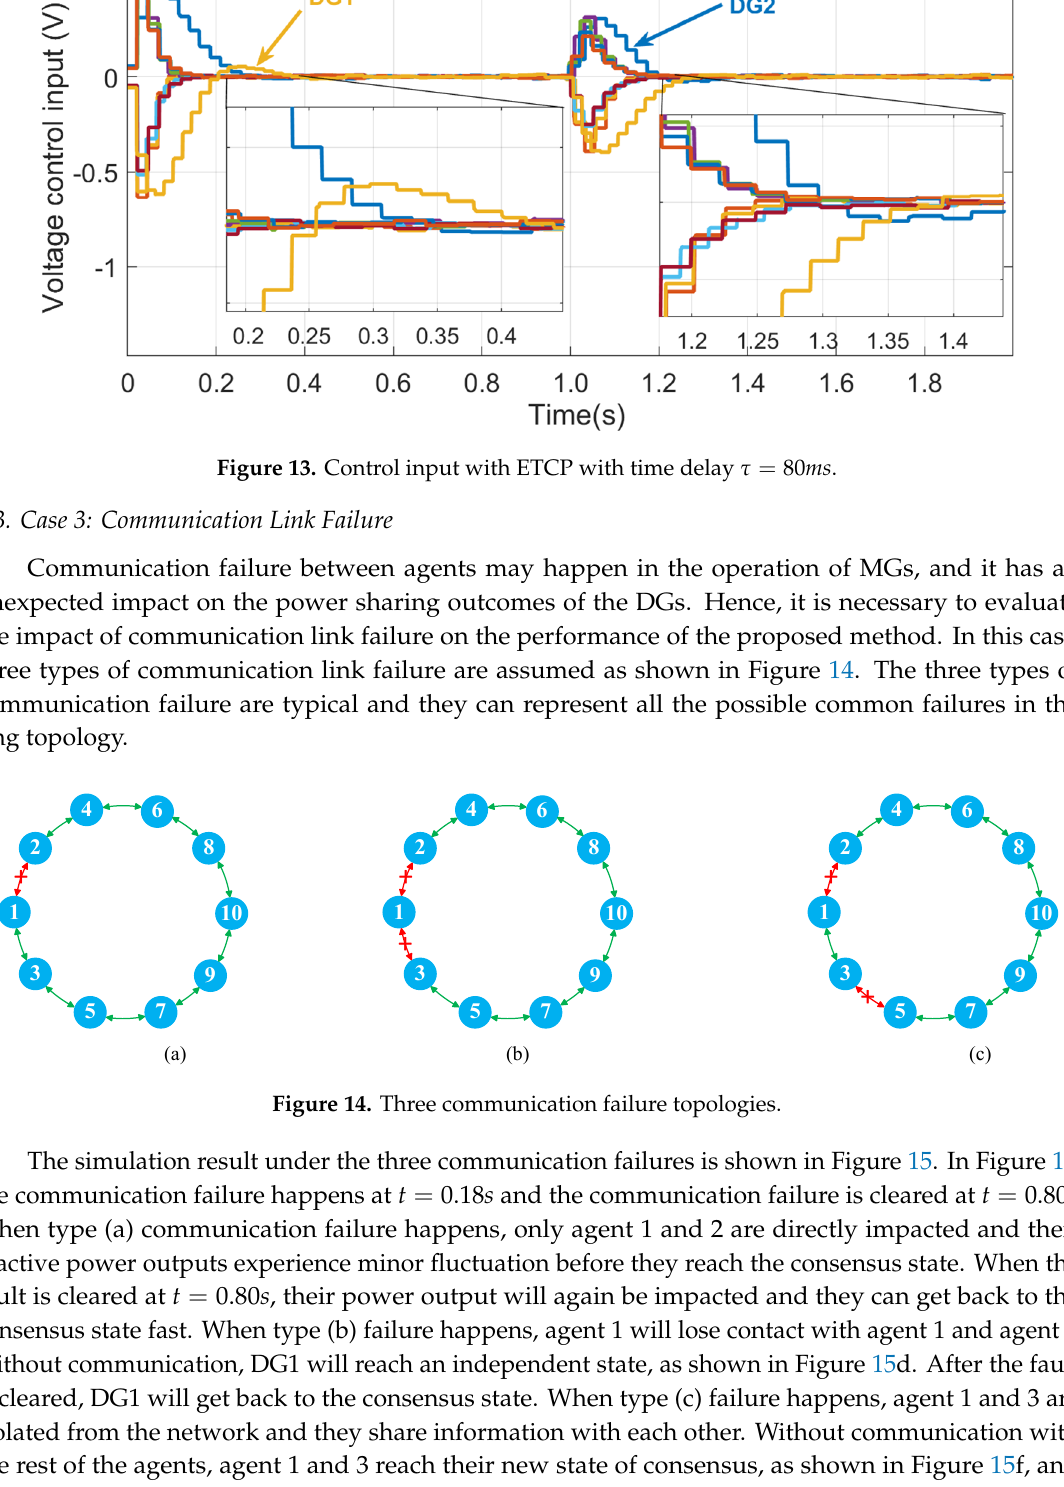
Figure 12. Control input with periodic communication with time delay